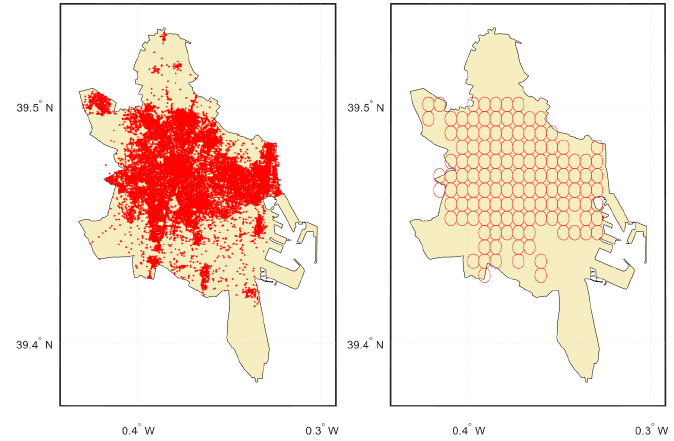
Figure 13. Spatial locations of logged events (2010–2019), and 118 basis functions placement in the city of